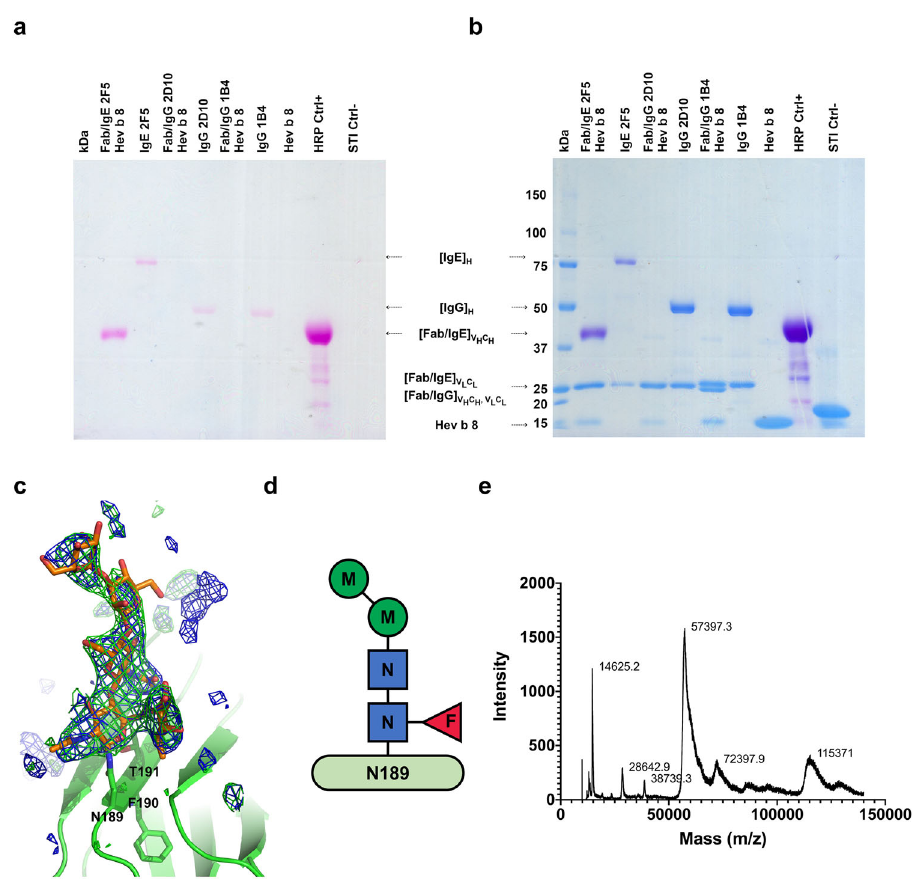
Fig. 3 IgE 2F5 and its Fab are glycosylated. a SDS-PAGE stained with the Pierce Glycoprotein Staining Kit. Lane one: Molecular weight markers. Second lane: the Fab/IgE 2F5 heavy chain (VH and C ε 1) is stained; Third lane: the complete IgE 2F5 heavy chain is stained; Fifth and Seventh lanes: Heavy chains of the complete IgG 2D10 and 1B4, which are glycosylated are stained. No stained bands were observed in the Fourth and Sixth lanes. Eighth and Tenth lanes, pro fi lin (rHev b 8) and the soy trypsin inhibitor (STI) were used as negative controls: The Ninth lane shows horseradish peroxidase (HRP) used as a positive control. b The same gel was stained with Coomassie Blue G250. The Fab/IgE 2F5 light chain, IgG light and heavy chains, rHev b 8 pro fi lin, and STI are observed. c Polder map contoured at 3 σ (blue) and omit map 3 σ (green) for the glycosylation at N189. d Composition of the oligosaccharide bound to N189 on the Fab/IgE 2F5, which comprises a core of di-mannose and fucose connected to the chitobiose core (GlcNAc2). Abbreviations: N, GlcNAc; M, mannose; F, fucose. e Mass spectra of DDDK-rHev b 8 (14,625 Da) and of the Fab/IgE 2F5 (57,397.3 Da). Lysozyme (14,100 Da) and bovine serum albumin (66,410 Da) were used to calibrate the spectrum. Interestingly, peaks of the Fab/IgE 2F5-DDDK-rHev b 8 complex (72,397.9 Da) and the dimeric Fab (115,371Da) were also detected; however, these two peaks were not calibrated.